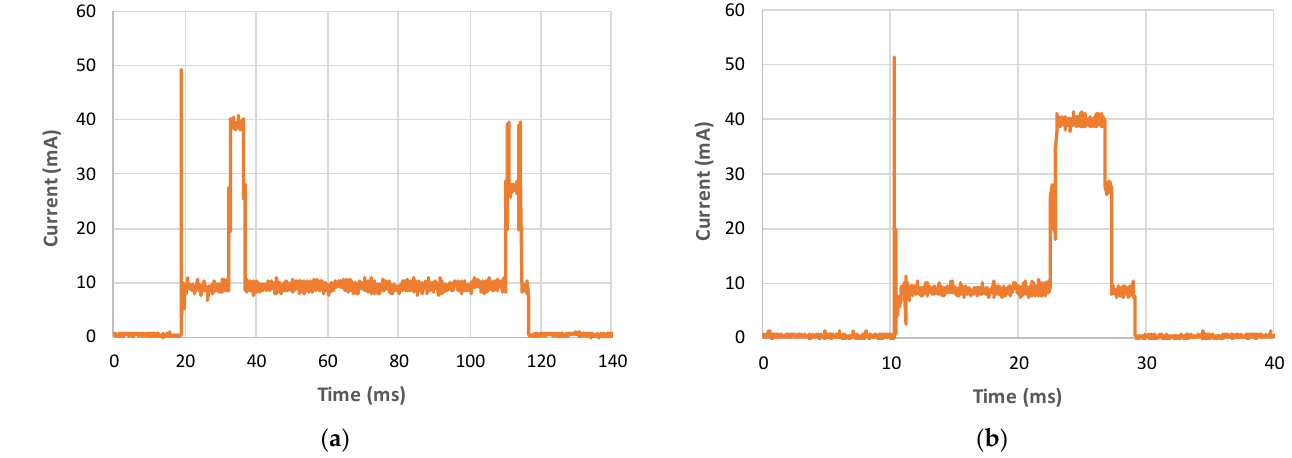
Figure 15. Current consumption: ( a ) with application ACK; ( b ) without application ACK.